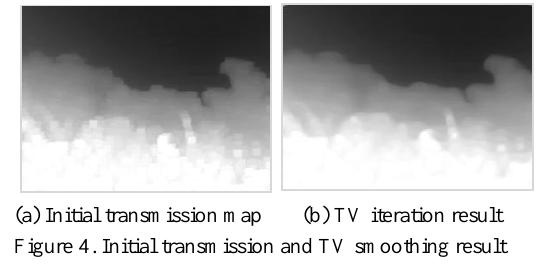
Figure 4. Initial transmission and TV smoothing result